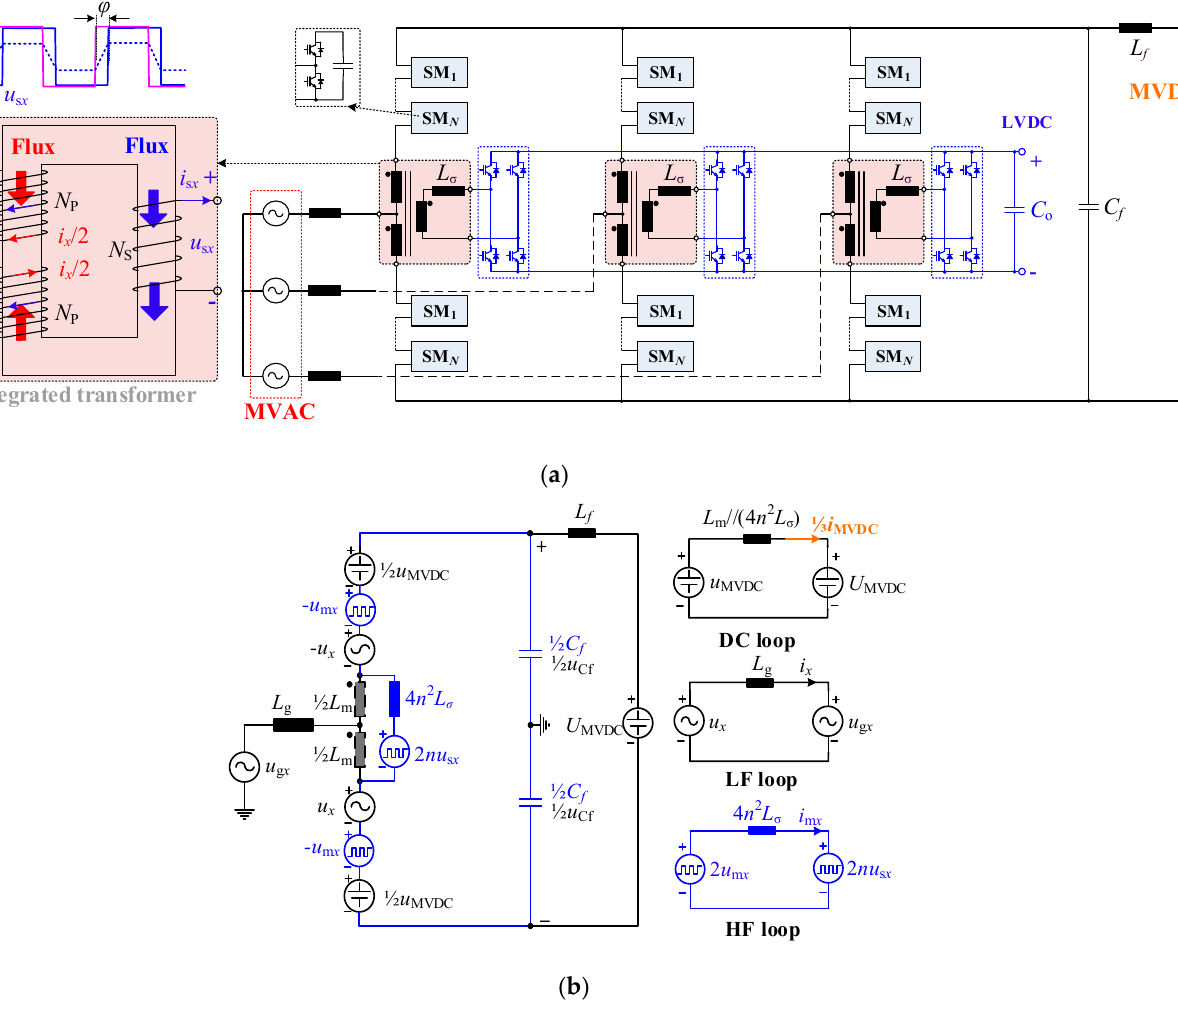
Figure 2. The proposed three-port PET: ( a ) circuit topology; ( b ) equivalent circuit of “ x ” phase (the blue line indicates the HF loop).